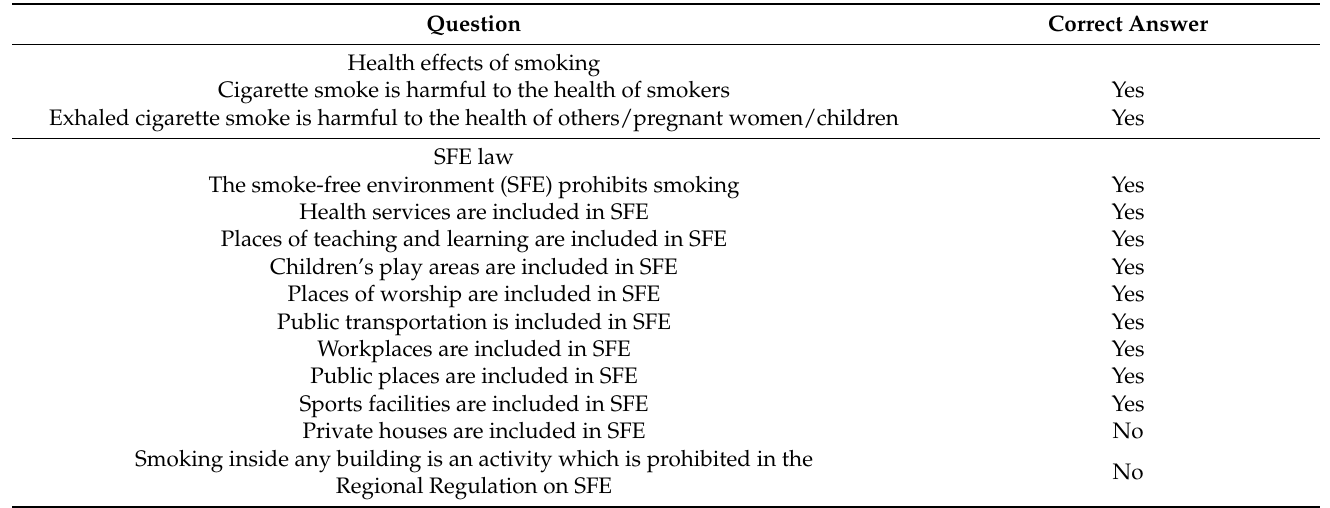
Table A1. Questions on the knowledge of the participants.